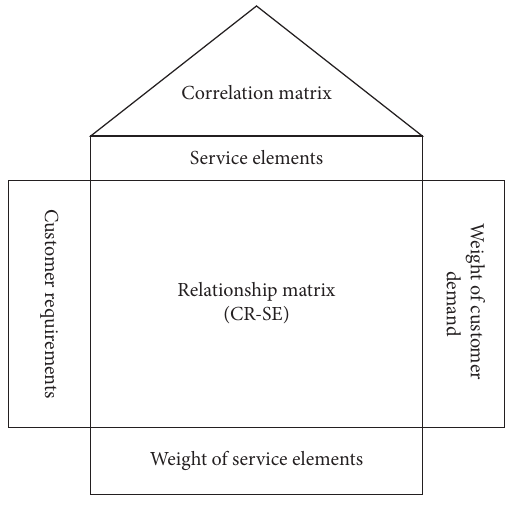
Figure 1: Basic composition of